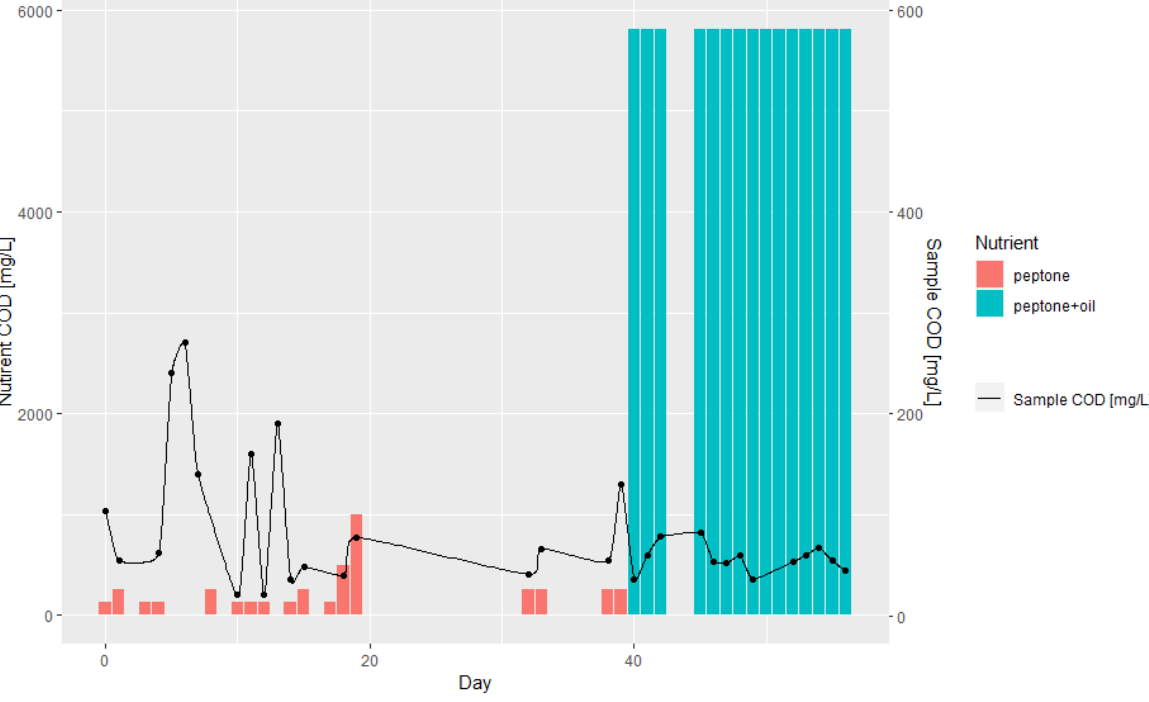
Figure 7. Relationship in time between chemical oxygen demand, nutrient medium, and filtered sample from the continuous-flow bioreactor.